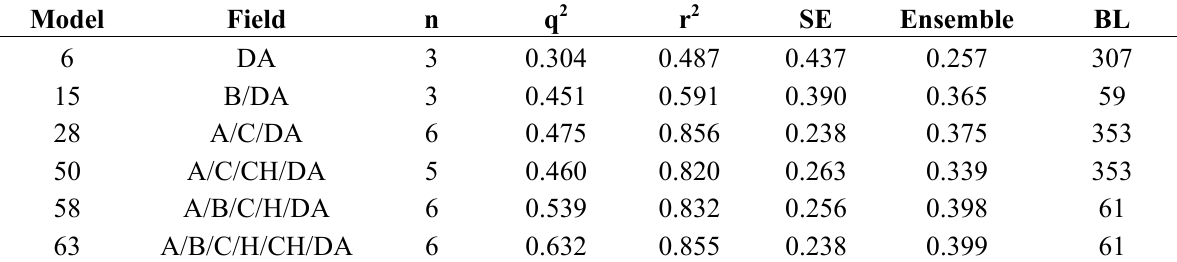
Table 1. Regression summary of HQSAR models of various combinations of fragment distinction parameters for 64 Ts as inhibitors of [ 3 H]MK-801 binding. A, atoms; B, bonds; C, connections; H, hydrogen atoms; CH, chirality; DA, donor & acceptor; q 2 , LOO cross validated correlation coefficient; r 2 , non-cross-validated correlation coefficient; SE, standard error of estimate; ensemble: average value of ensemble q 2 *; BL, best hologram length; n, number of components used in the PLS analysis.